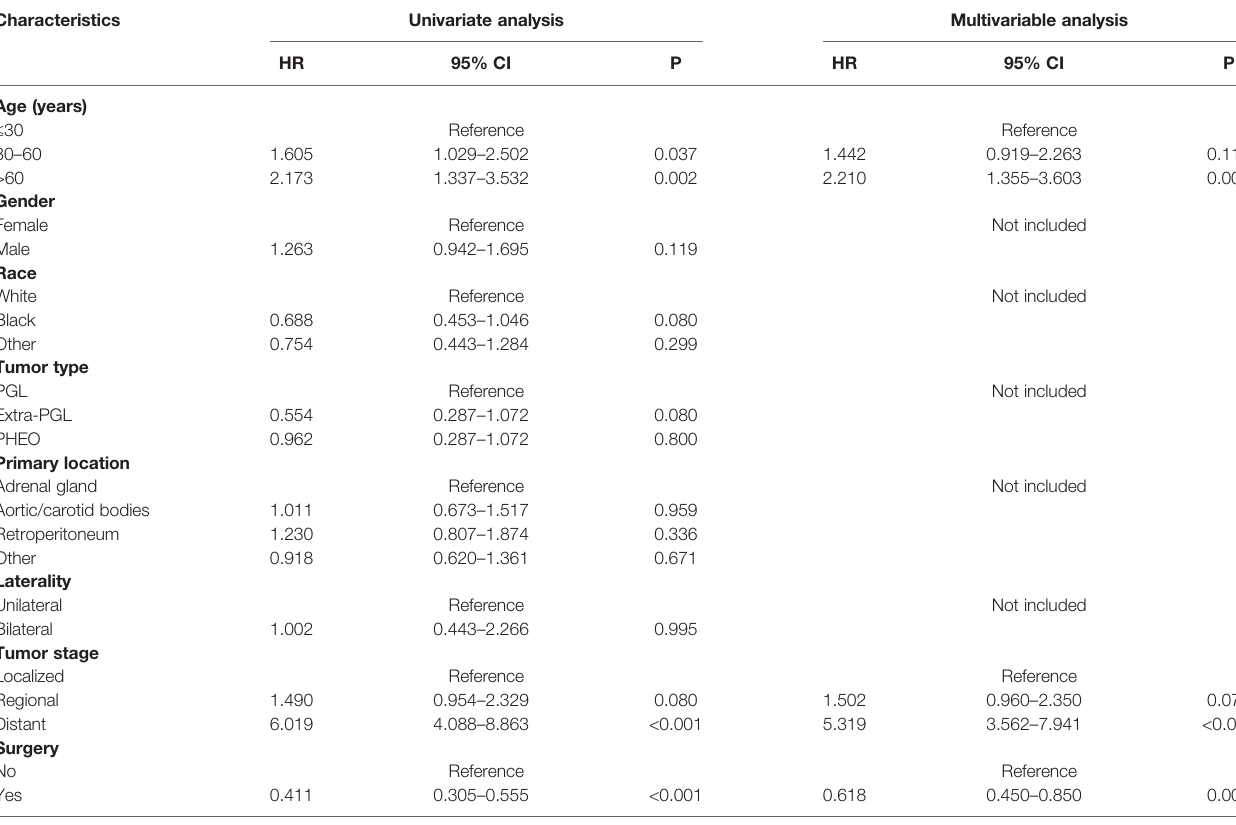
TABLE 3 | Univariate and multivariate Cox proportional hazards regression analyses of variables associated with cancer-speci fi c survival.